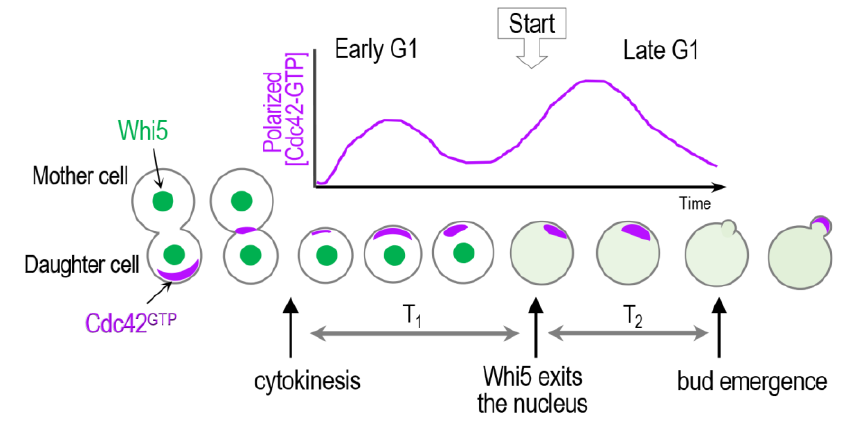
FIGURE 3: A scheme of biphasic